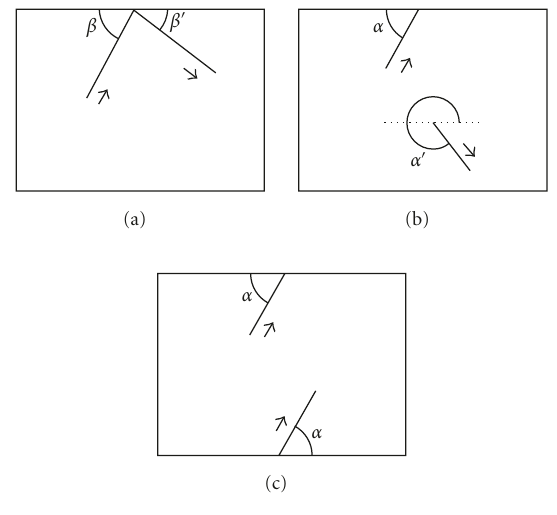
Figure 11: Types of border